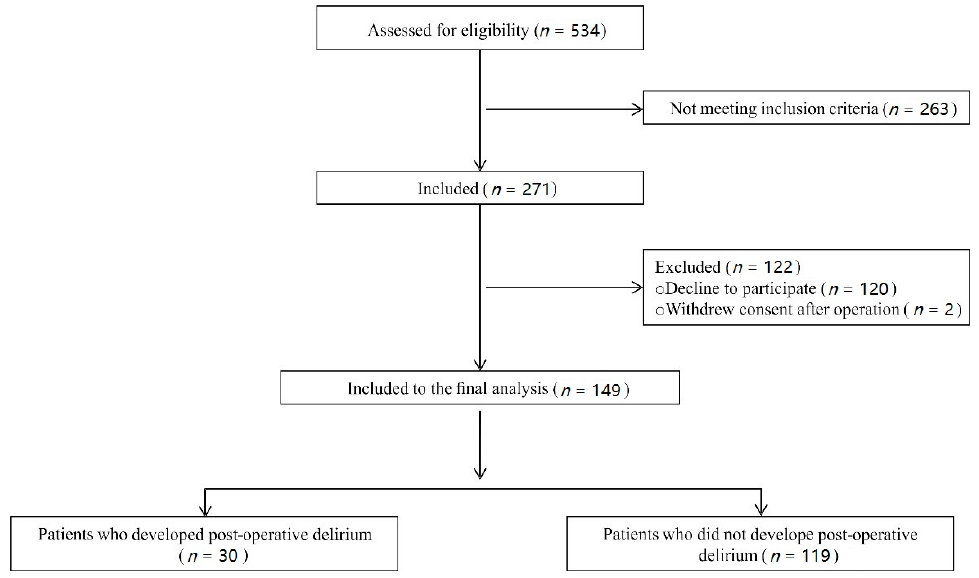
Figure 1. Flow diagram of the study.